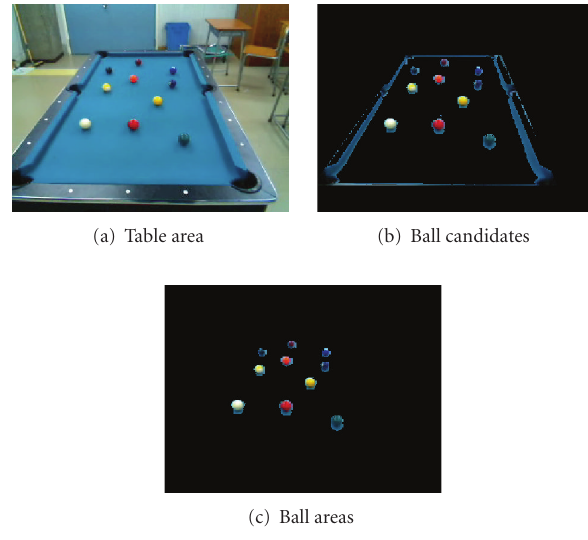
Figure 6: Extraction of ball